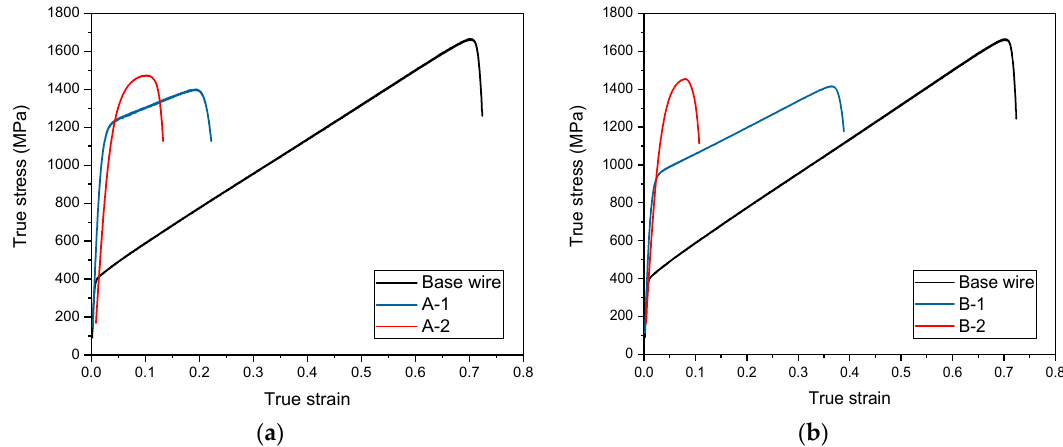
Figure 5. The true strain-stress curves of two sets of drawn wires, true strain-stress curves of drawing process A ( a ) and B ( b ).